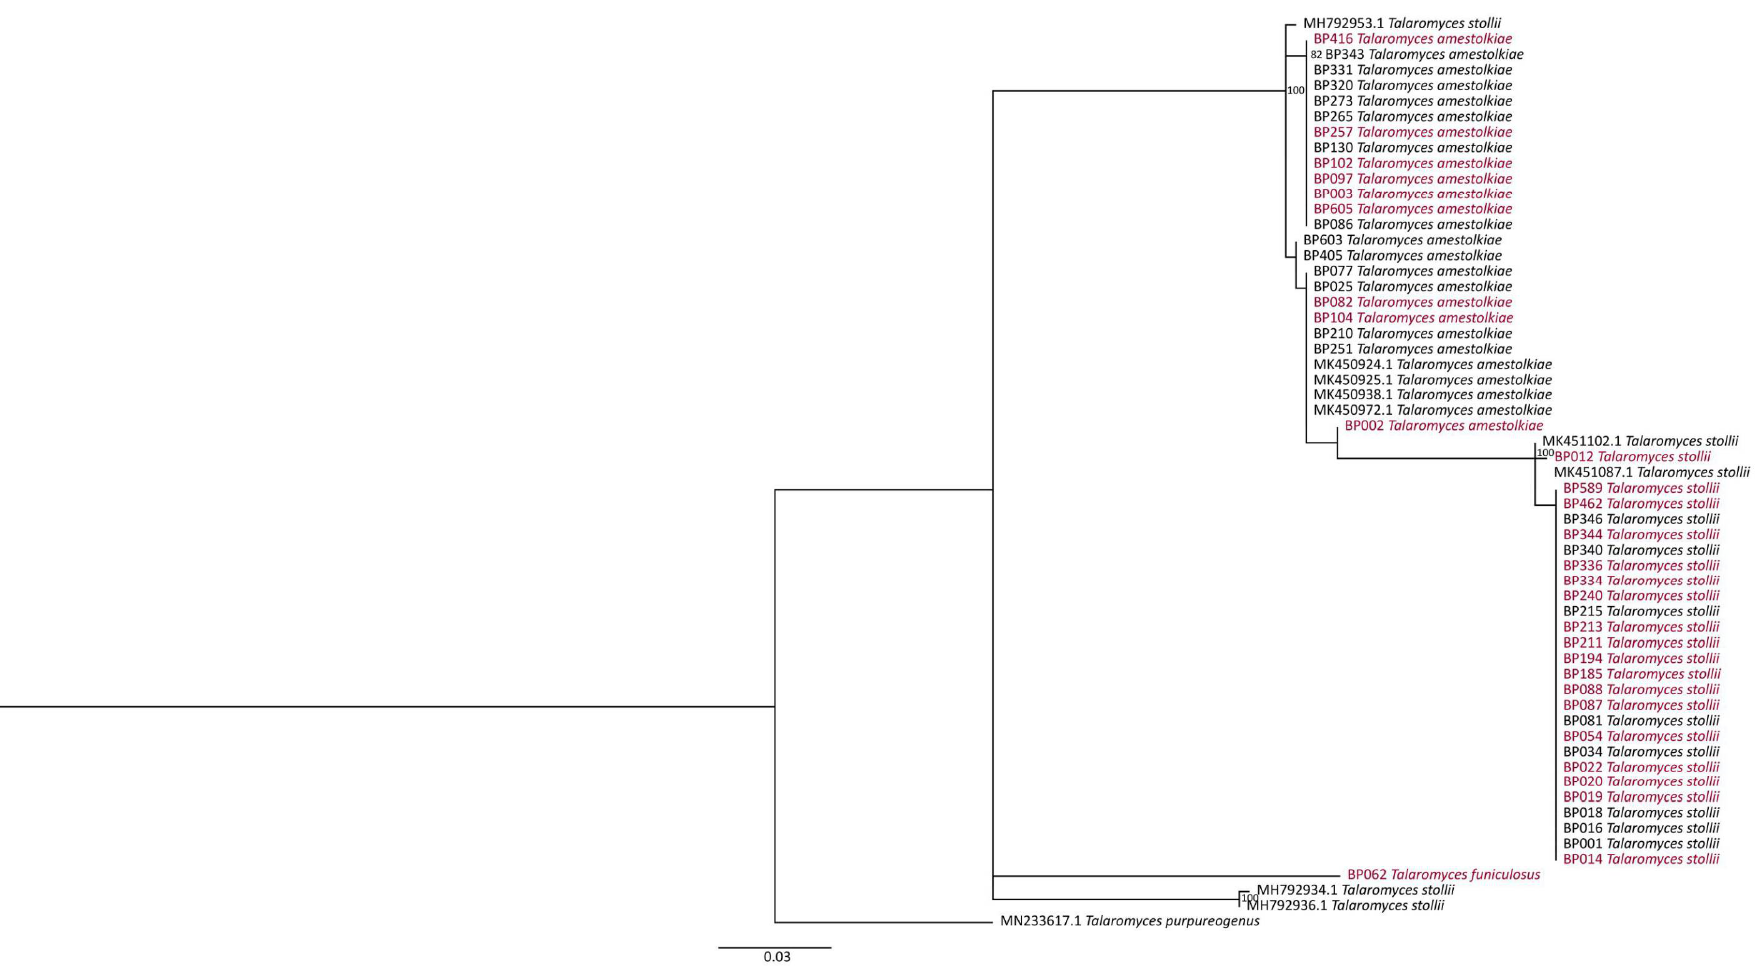
Figure 8. Phylogenetic tree of Talaromyces species computed by Maximum Likelihood (ML) analysis (TPM2+G as the best fit model) and based on a β–tubulin sequences dataset. Only ML bootstrap branches that support values greater than 70% are shown. Strains isolated from infected (IF) and healthy fruitlets (HF) are indicated in red and black, respectively. The tree is rooted with T. purpureogenus accession MN233617.1.